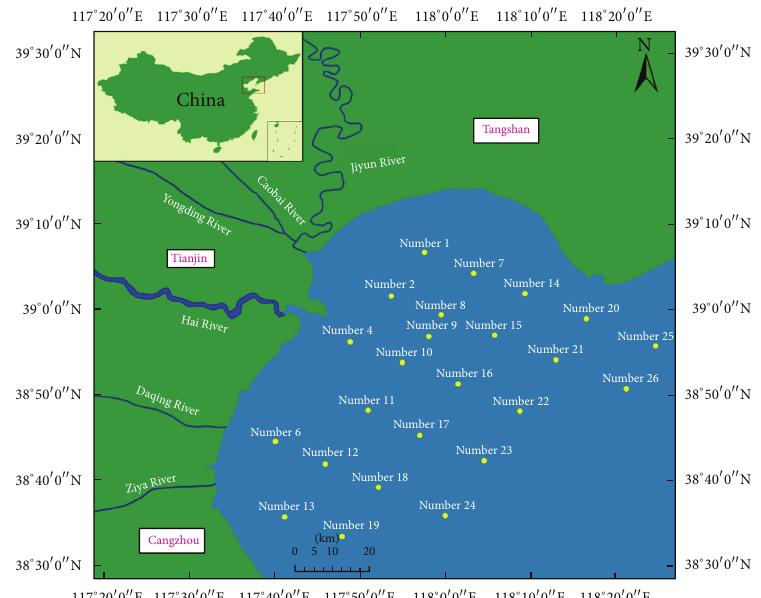
Figure 1: Sampling sites in Bohai